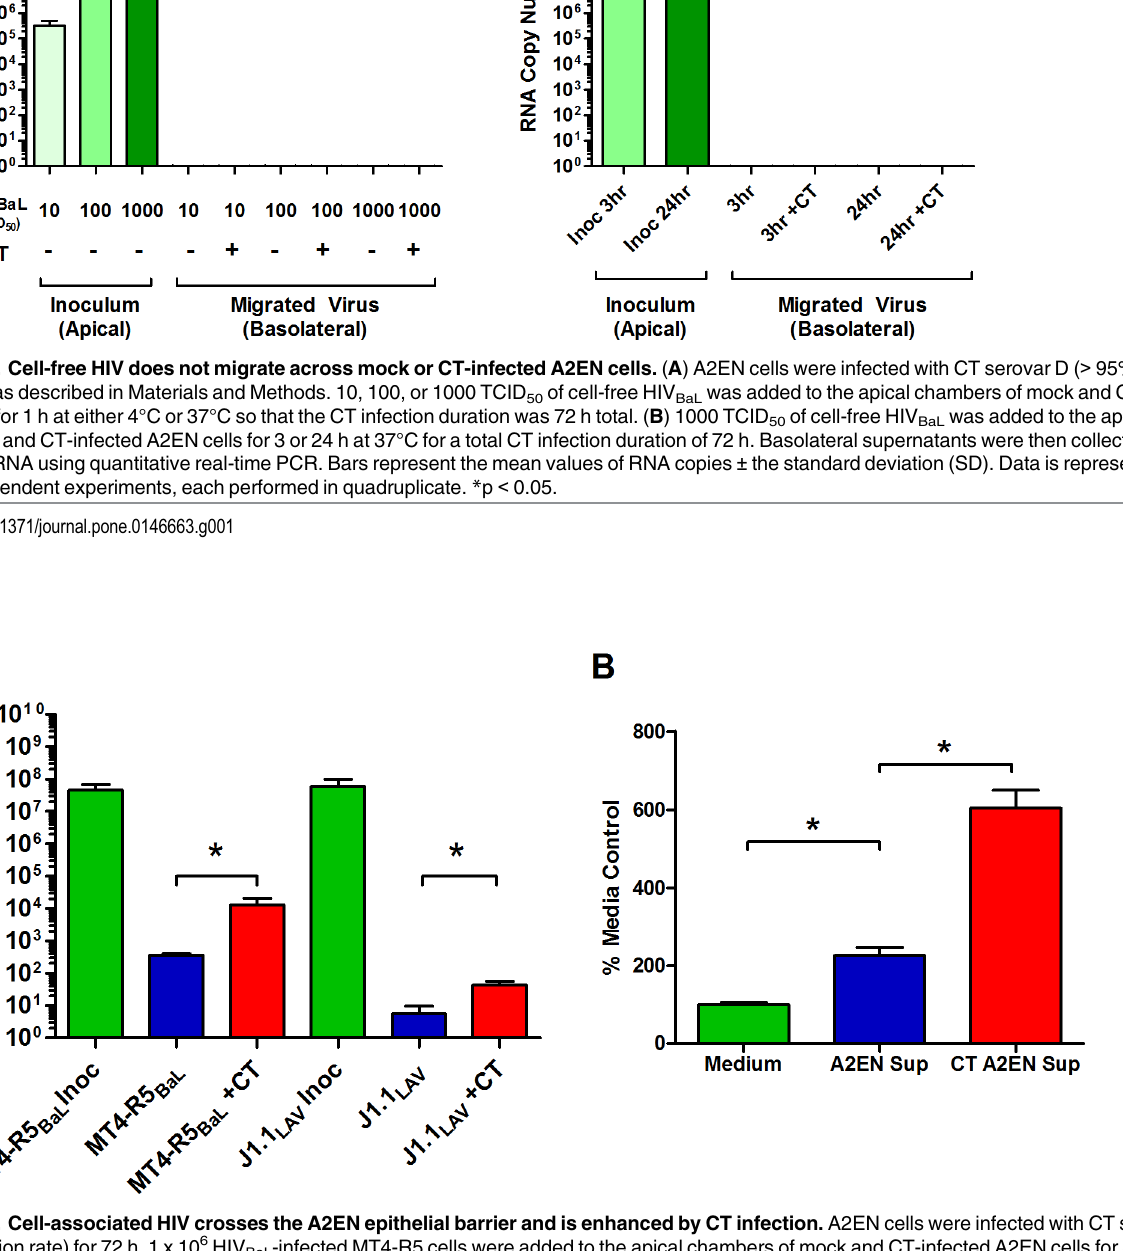
PLOS ONE | DOI:10.1371/journal.pone.0146663 January 5, 2016 7 /